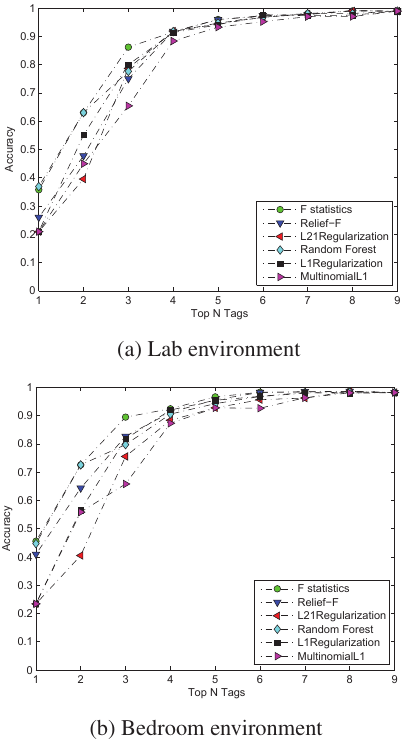
Figure 12: Posture classification comparison with Top N tag selection in (a) lab and (b) bedroom environments